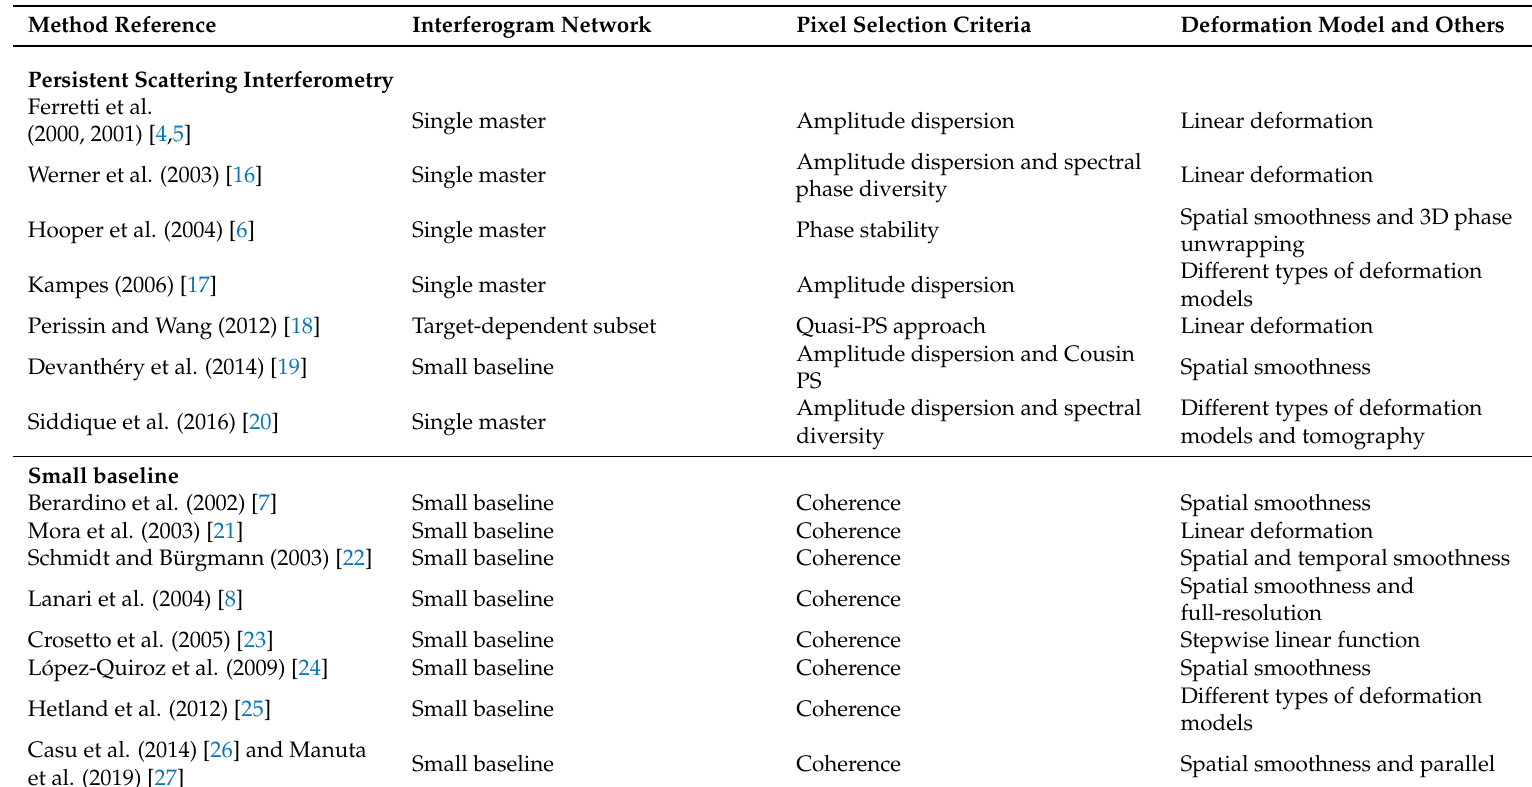
Table 1. Characteristics of the main Interferometric Synthetic Aperture Radar (InSAR) time series